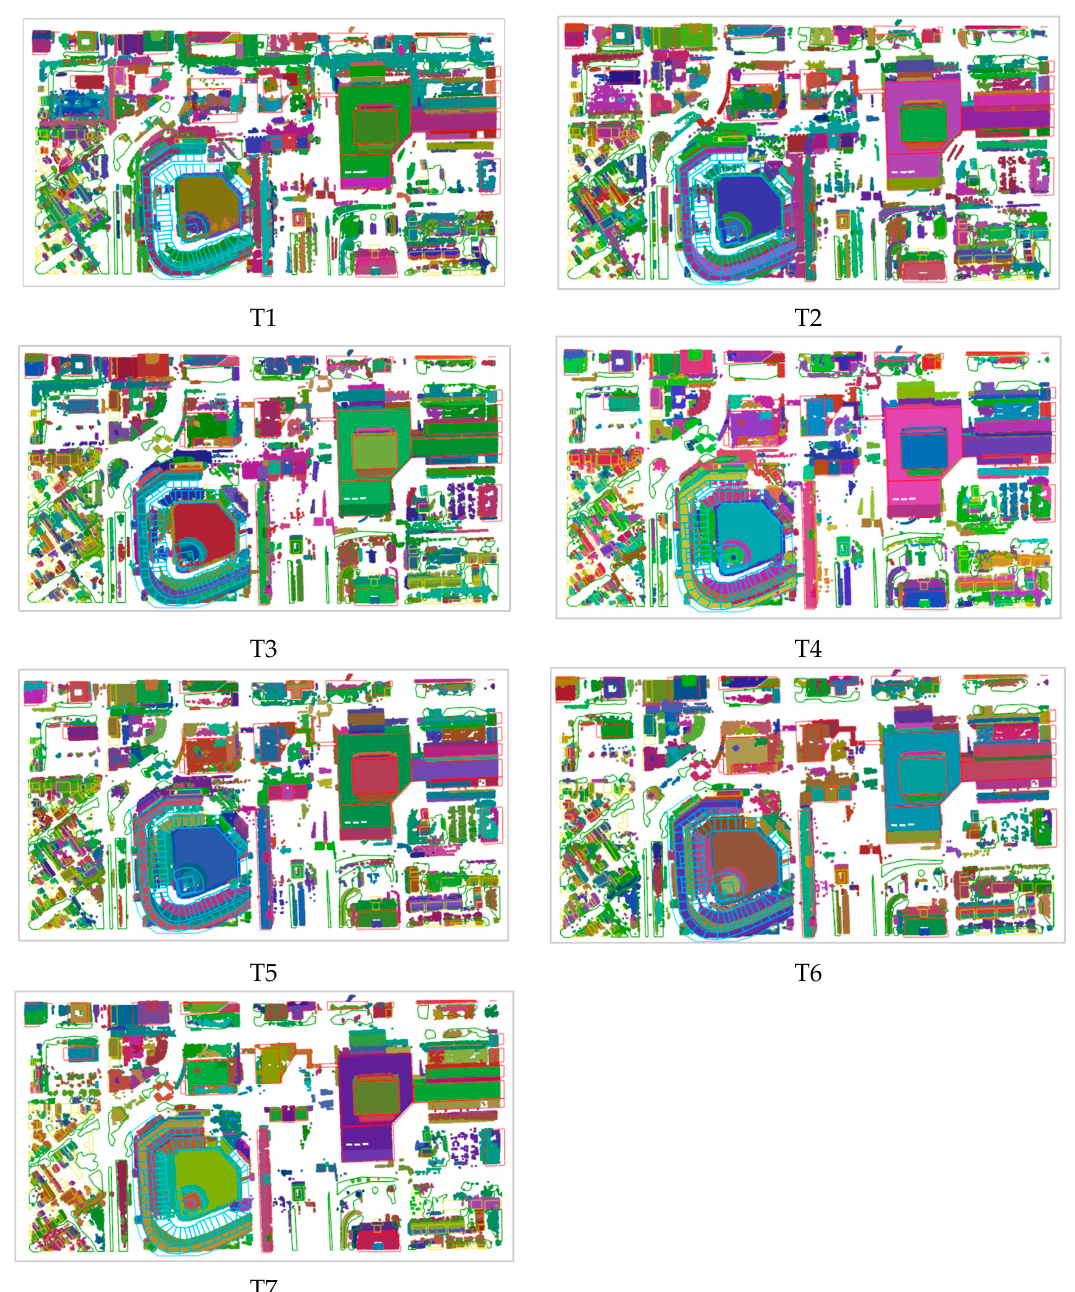
Figure 11. Airborne laser scanning data segmentation result maps using X , Y , Z , R, G, B fields.